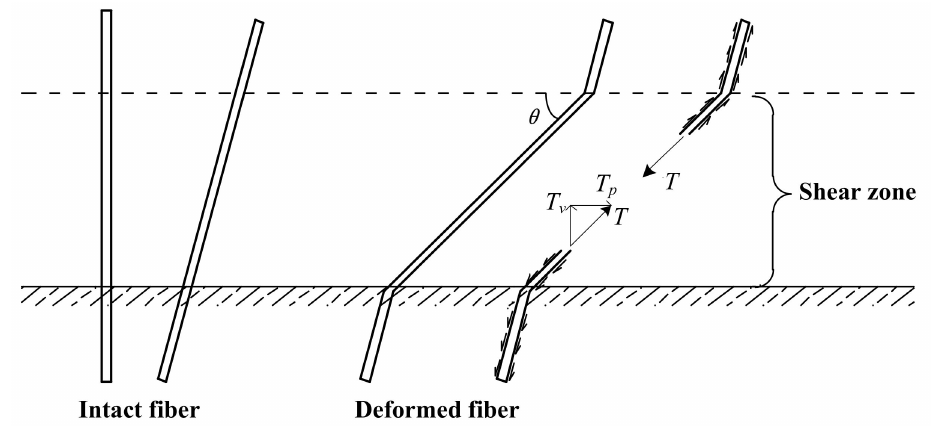
Figure 13. Long fiber reinforcement principle (Modified from